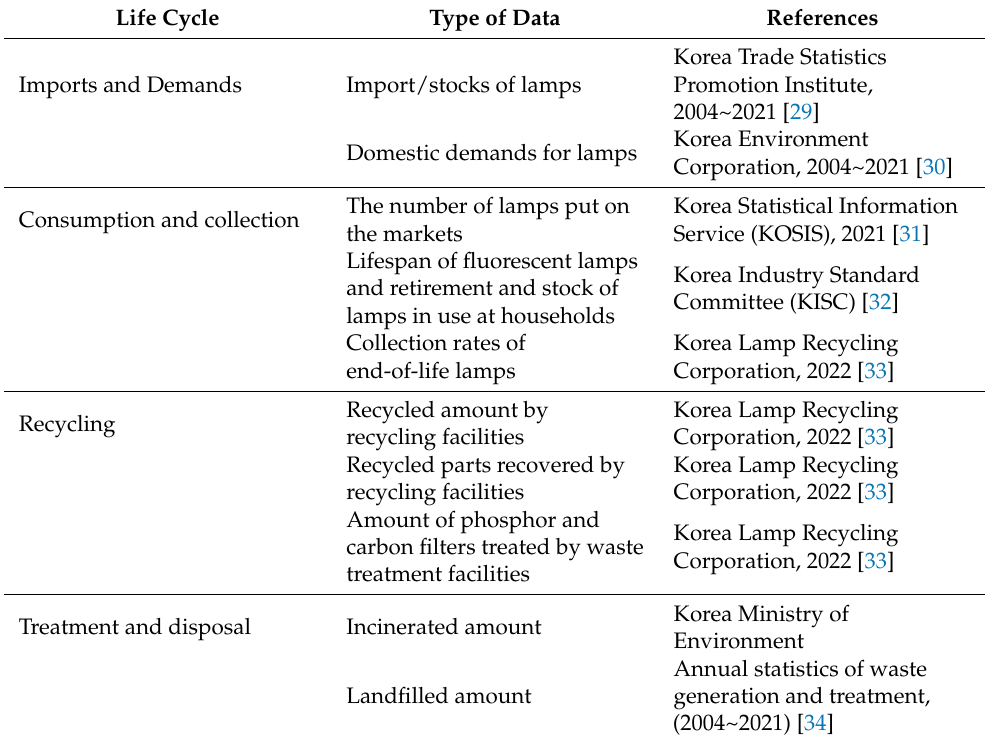
Table 1. Data collection and acquisition for material flow analysis for fluorescent